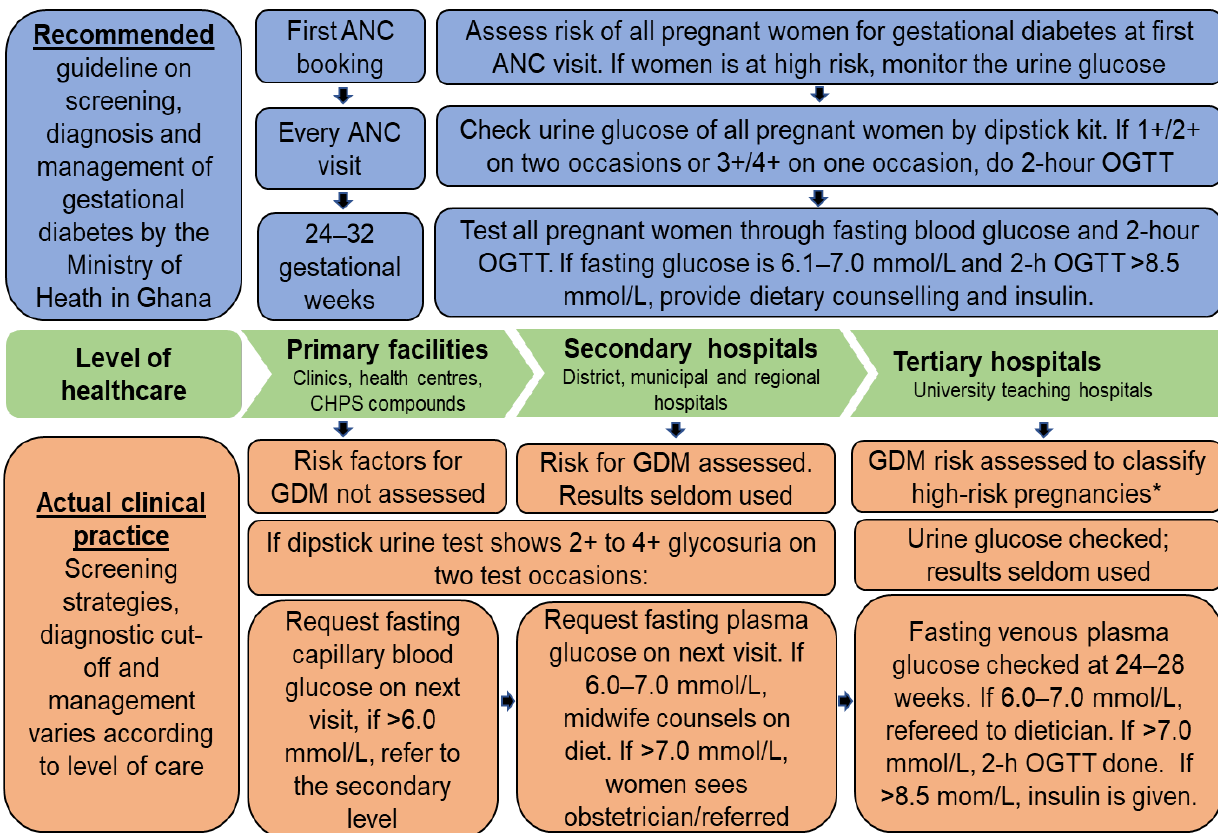
Figure 2. Recommended standard of care for GDM detection in Ghana vis-à-vis the actual clinical practice. Note: Author designed. ANC, antenatal care clinic; 2-h OGTT, two-hour oral glucose tolerance test; GDM, gestational diabetes mellitus; CHPS, Community Health-Based Planning Services.